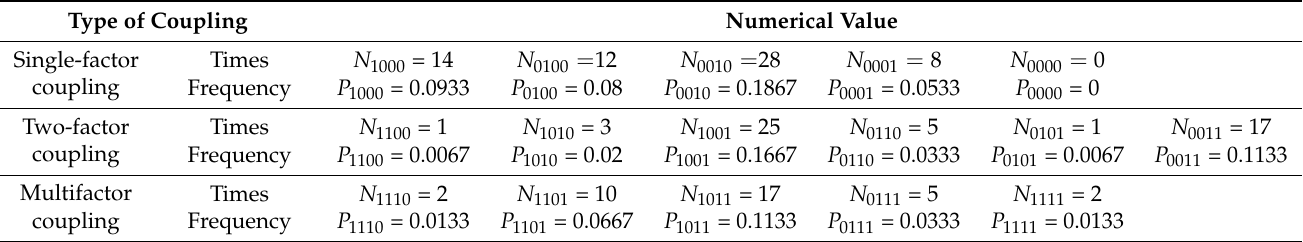
Table 4. Number of risk couplings and frequency of